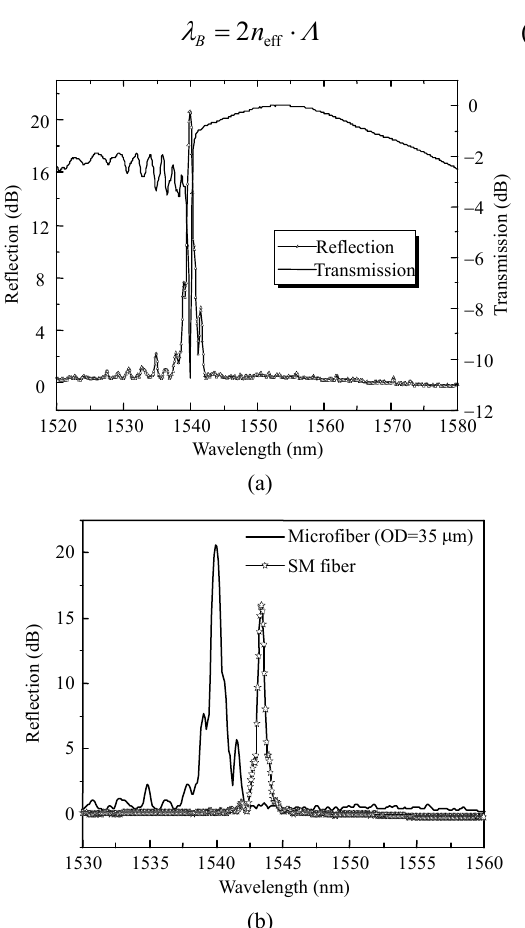
Fig. 2 Spectrum of microfiber FBG: (a) transmission and reflection spectrum of FBG in a microfiber and (b) reflection spectrum of single mode fiber FBG and microfiber